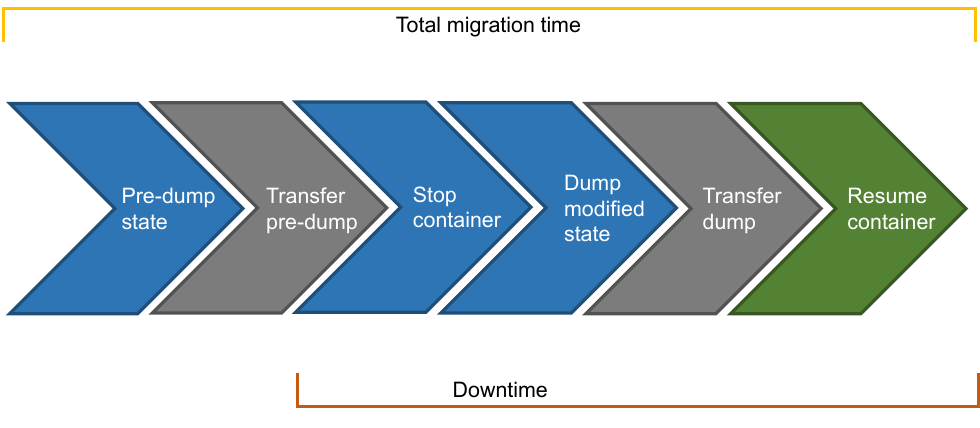
Figure 4. Pre-copy